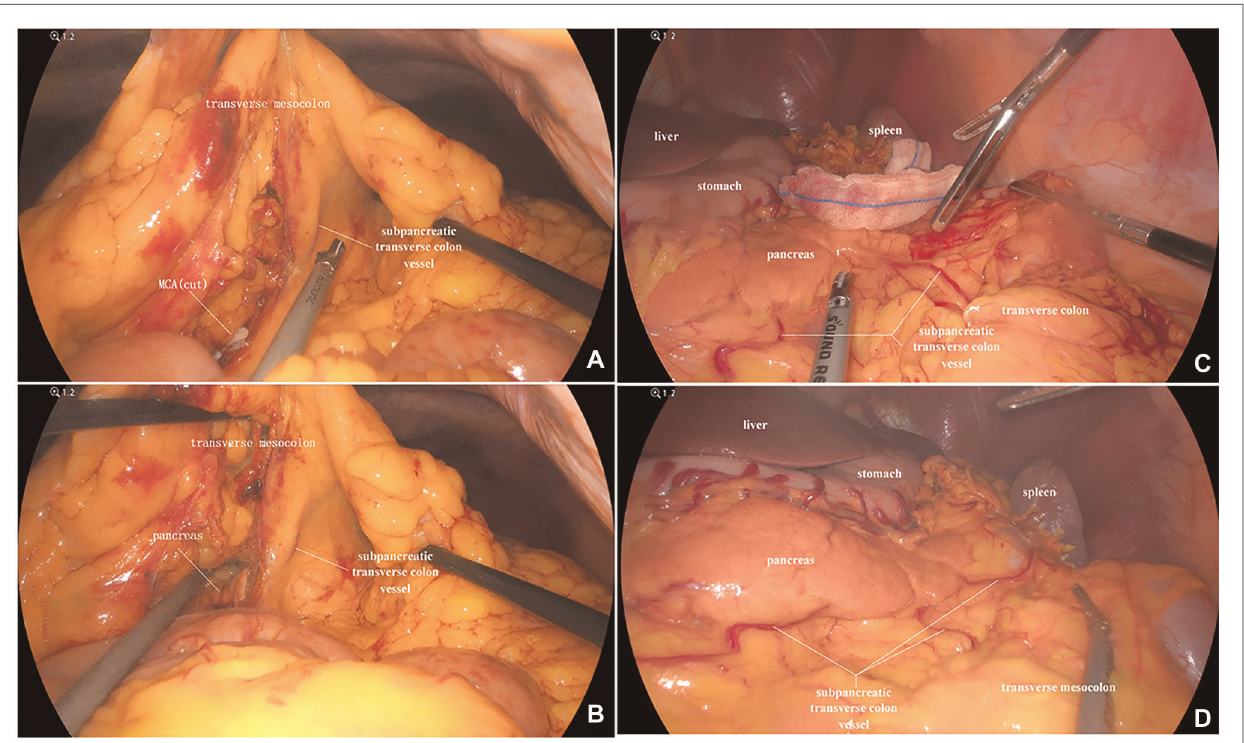
FIGURE 1 | ( A ) A vessel was observed running through the transverse mesocolon, supplying blood to the transverse colon, except for the MCA. ( B ) The vessel which emanated from the inferior margin of the pancreas, supplied the transverse colon. ( C ) Two vessels were clearly observed. ( D ) Three vessels were clearly observed. MCA, middle colic